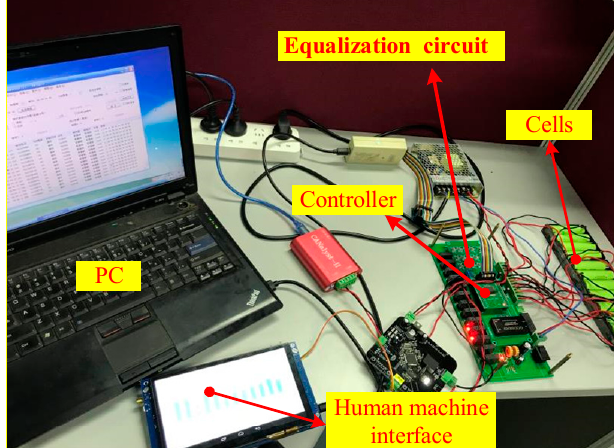
Figure 13. Experimental platform of the proposed equalizer.